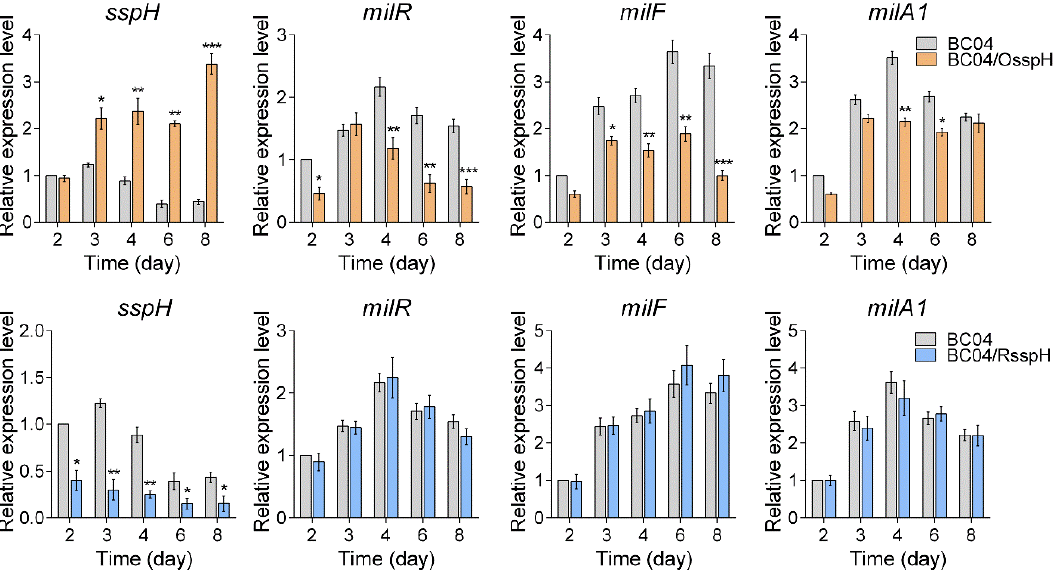
Figure 3. The qRT-PCR analysis of sspH , milR , milF and milA1 in BC04, BC04/OsspH and BC04/RsspH. The transcriptional levels of related genes are presented relative to that of BC04 on day 2. 16S rRNA was used as the internal control. Data are presented as the averages of three triplicates. Error bars show standard deviations. * p < 0.05, ** p < 0.01, *** p < 0.001.